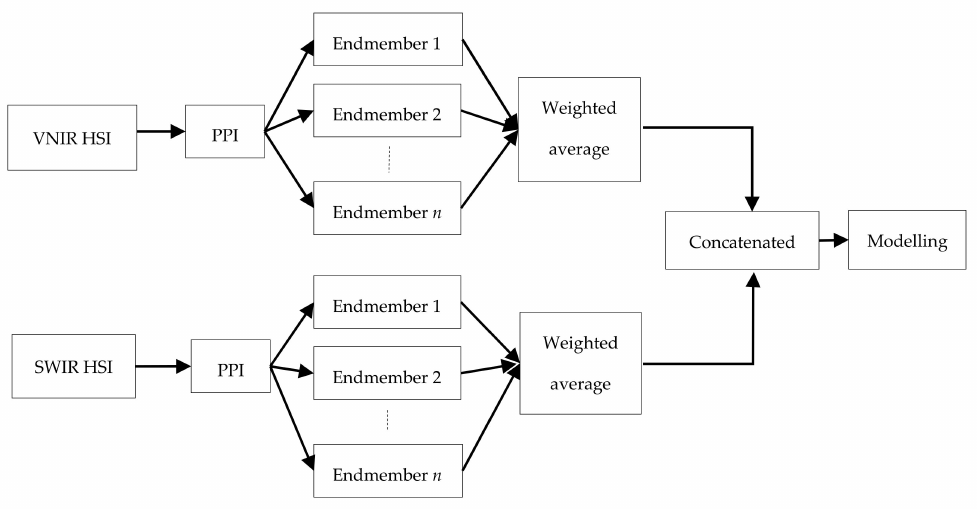
Figure 3. The steps for the fusion of the VNIR and SWIR data using a mid-level data fusion approach (HSI stands for hyperspectral